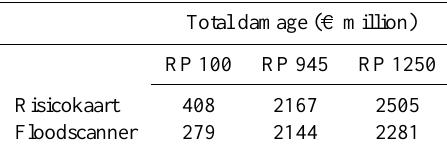
Table 1. Number of inundated cells in the observed dataset, the modelled dataset, and number of cells that are inundated in both datasets. Of the cells that were inundated in the modelled dataset only, approximately 1850 cells are located in locations a and b of Figs. 4 and 5.